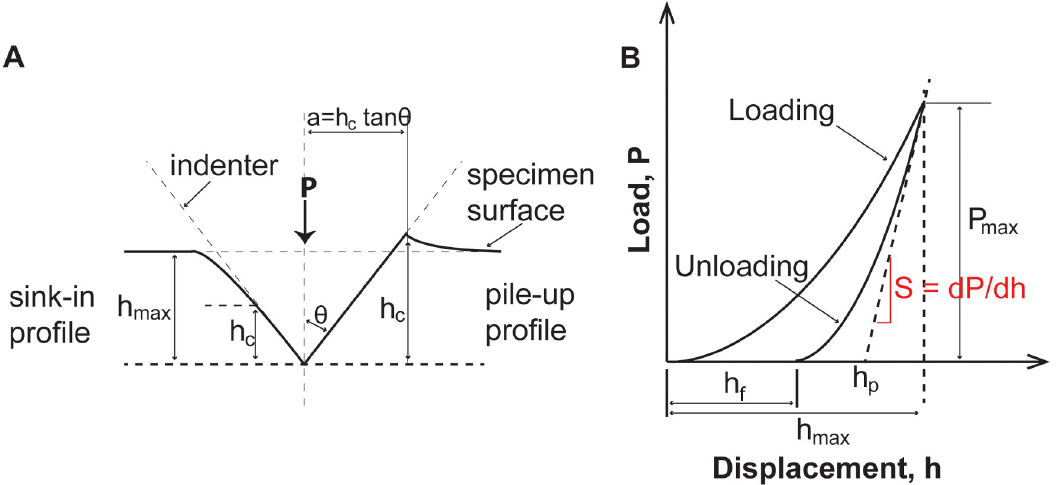
Fig 4. Material reaction during the nanoindentation process. A: Schematic drawing showing the surface displacement during indentation; B: A typical indentation P-h curve where h c is the maximum true contact displacement during loading, P max refers to the maximum load applied during the indentation cycle, S is the initial unloading stiffness, h f is the final plastic depth from the P-h curves, h s is the residual depth after complete unloading and h max is the